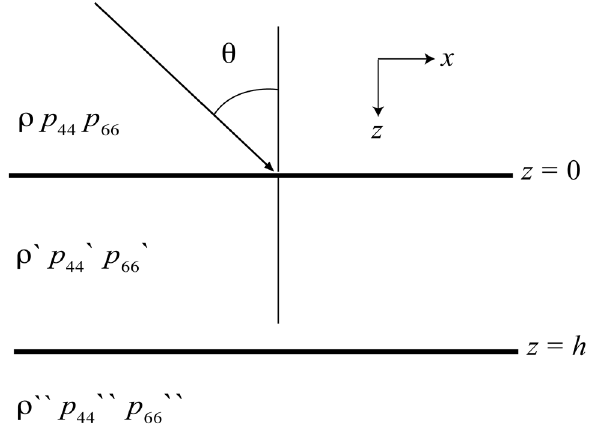
Figure 1. Plane wave propagating through a layer. The viscoelastic properties are